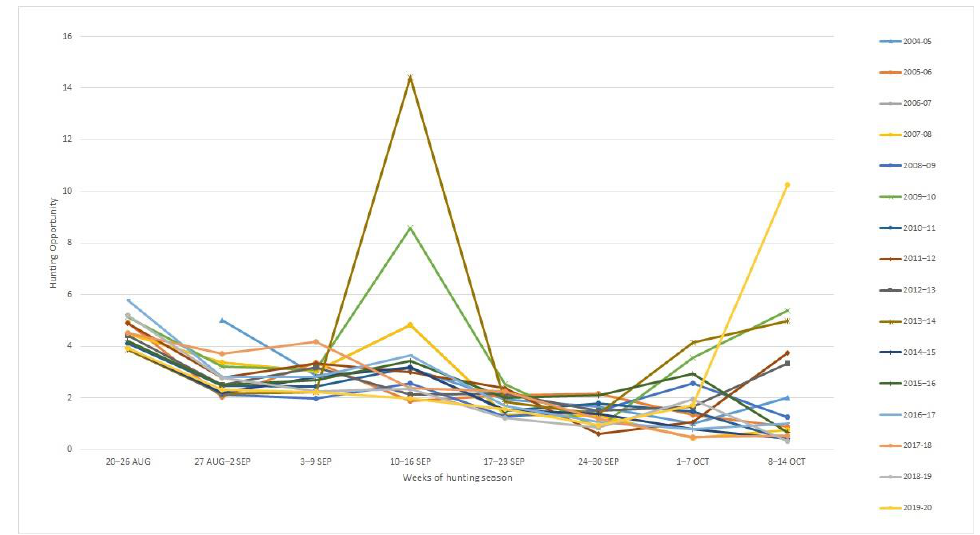
Figure 1. Evolution of mean annual hunting opportunity per hour per hunter for turtle doves during the hunting seasons 2004/05 and 2019/20 in Greece.